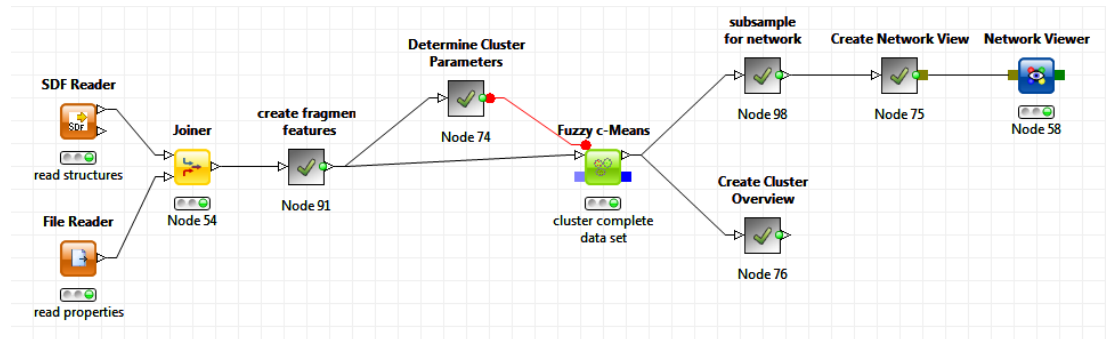
Figure 17: A workflow for the model and visualization of a molecular space.